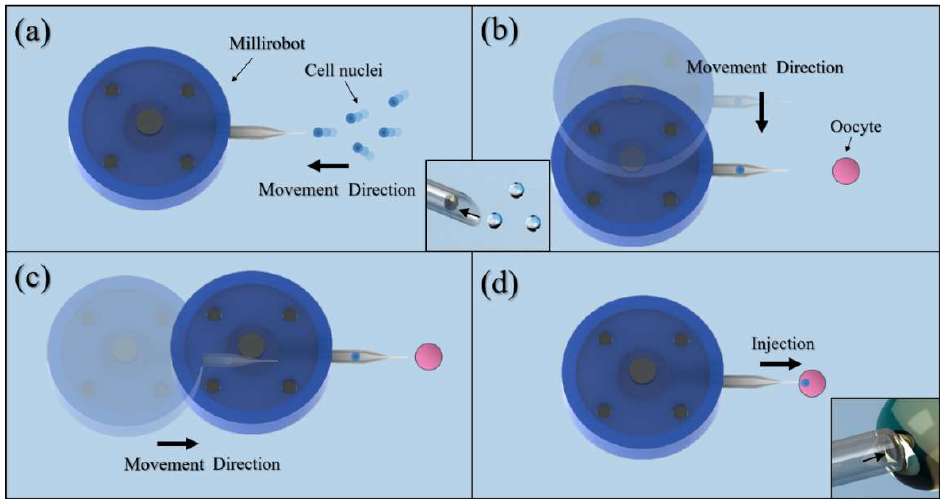
Figure 9. Concept of experimental process. ( a ) The process of cell nuclei absorption; ( b ) Millirobot motion along the Y axis; ( c )Millirobot motion along the X axis; ( d )The injection of cell nuclei.